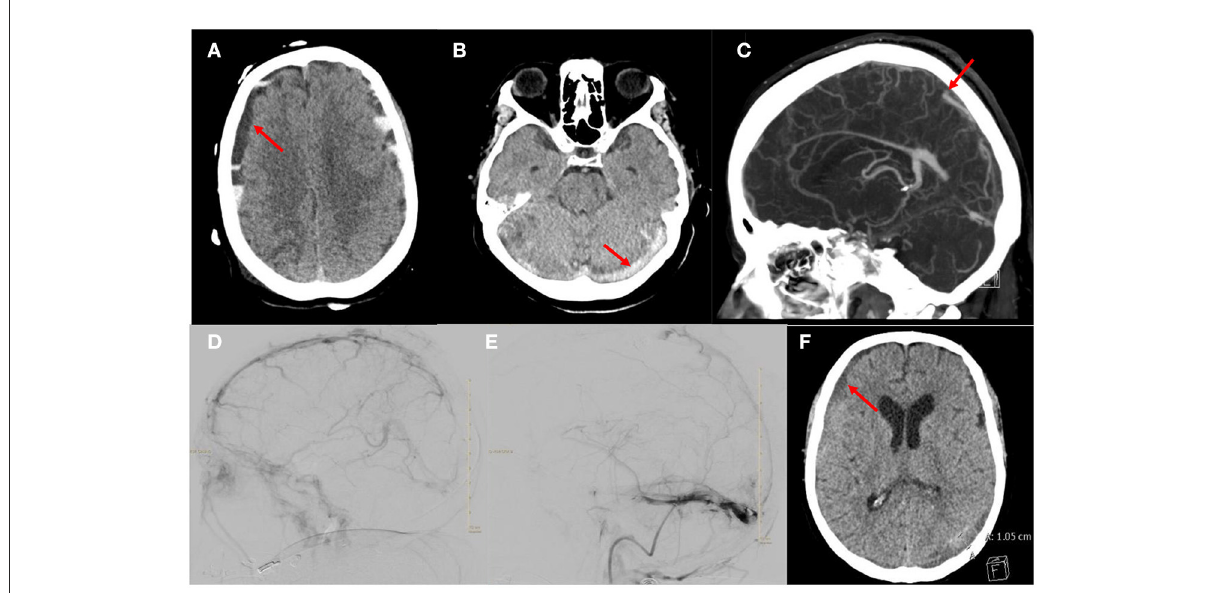
FIGURE1 Images from the patient who received mechanical thrombectomy and anticoagulation for aSDH with CVST. (A) Axial head CT demonstrating the mixed density acute subdural hematoma. (B) Axial head CT demonstrating hyperdensity in the torcula and transverse sinuses suggestive of acute thrombosis. (C) Sagittal CTV demonstrating occlusion of the SSS, straight sinus and torcula along with generalized venous congestion. (D) Right ICA injection, lateral projection of late venous phase demonstrating thrombus in the SSS and partial occlusion of the straight sinus and occlusion of the transverse sinuses. (E) Venogram of right sigmoid sinus, lateral projection after thrombectomy and tPA infusion showing improvement in drainage of the SSS and transverse sinus. Note there is a persistent non-occlusive thrombus of the transverse sinus. (F) Axial head CT demonstrating decreased size of the subdural